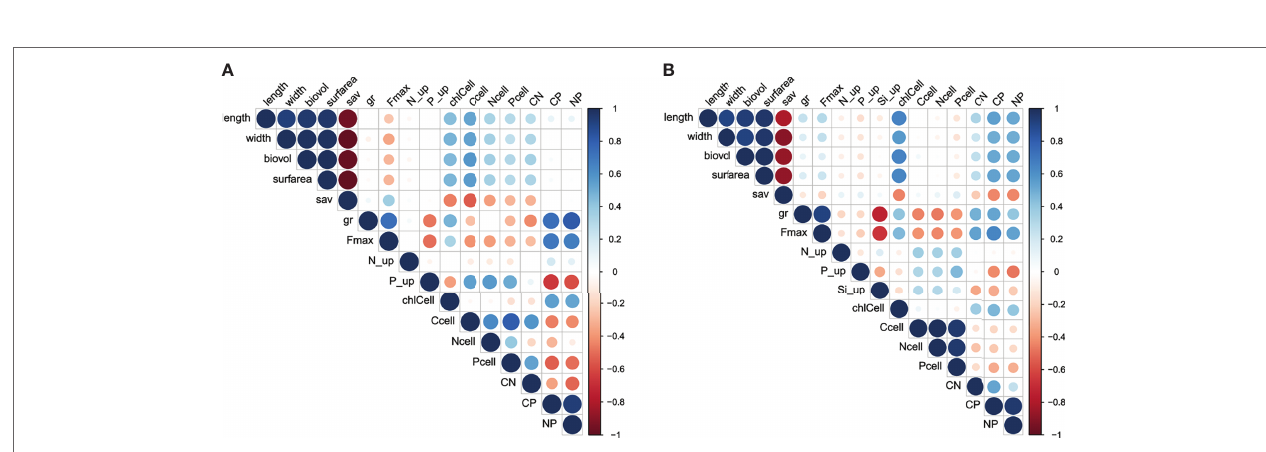
FIGURE 2 | Correlation matrix of the different traits measured from different (A) A. ostenfeldii and (B) S. marinoi strains grown under different salinity